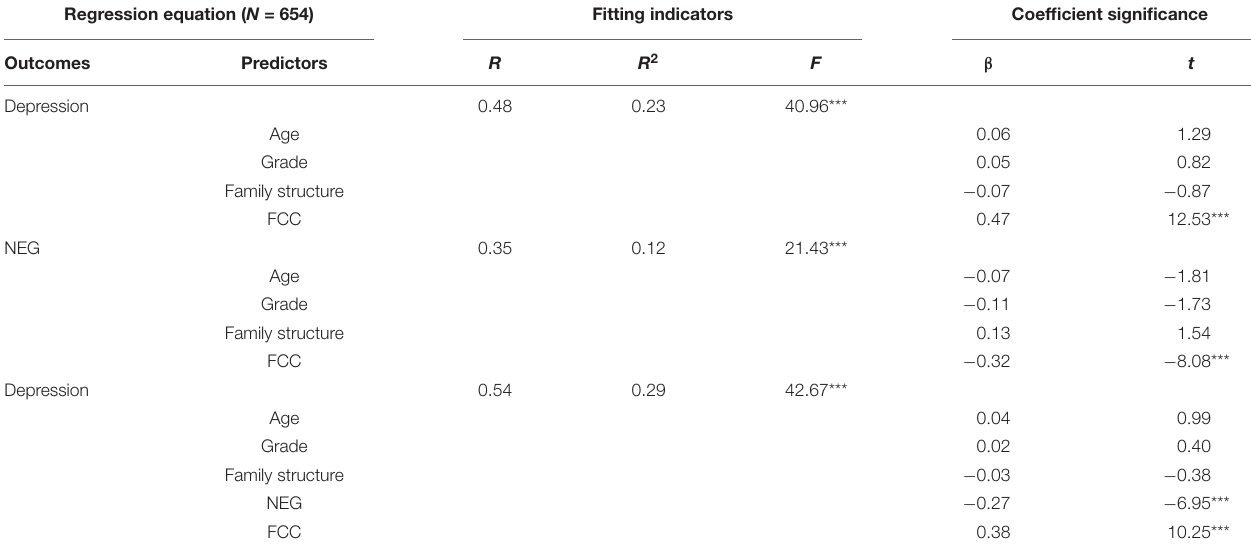
TABLE 5 | Results for the mediation effect of NEG. Regression equation ( N = 654) Fitting